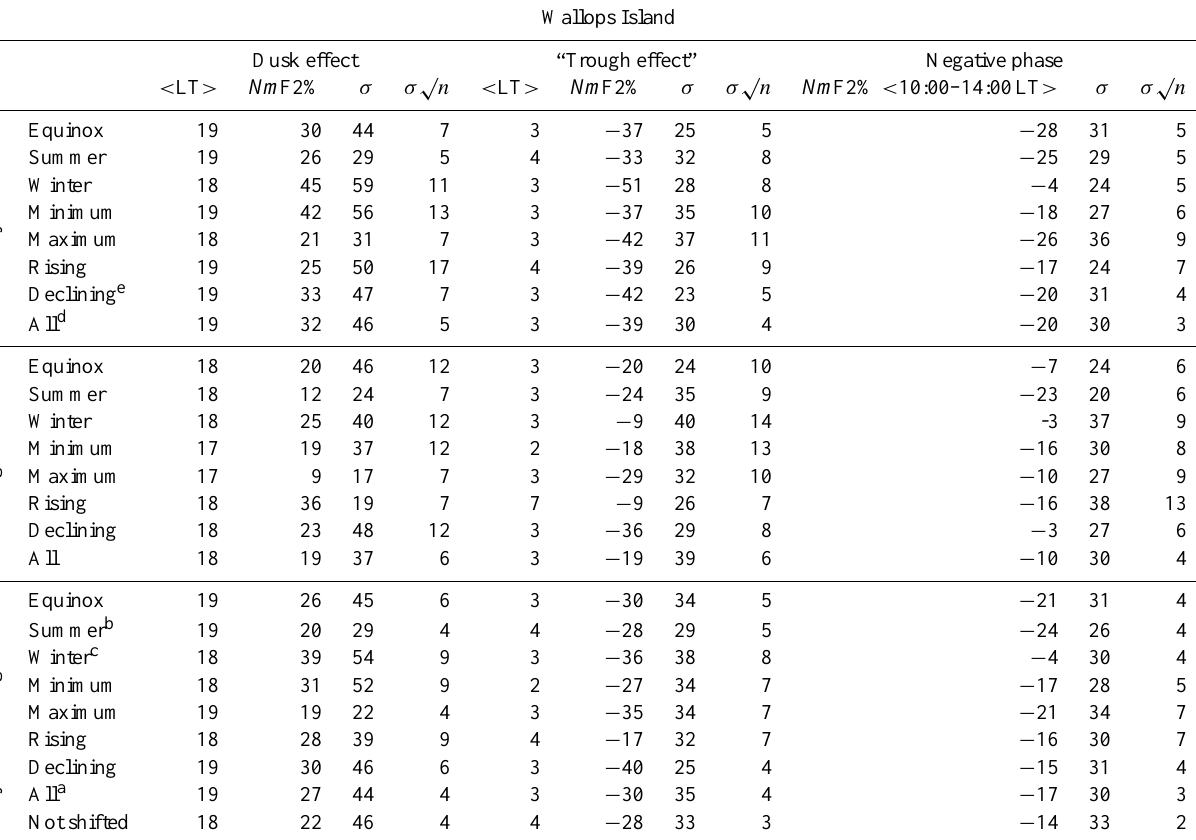
Table 2. Summary of ionospheric storm characteristic patterns for three common features seen at Wallops